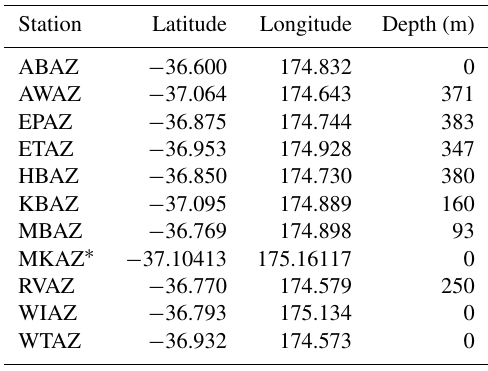
Table 1. Coordinates of the AVSN short-period seismometers and the broadband station MKAZ. Station Latitude